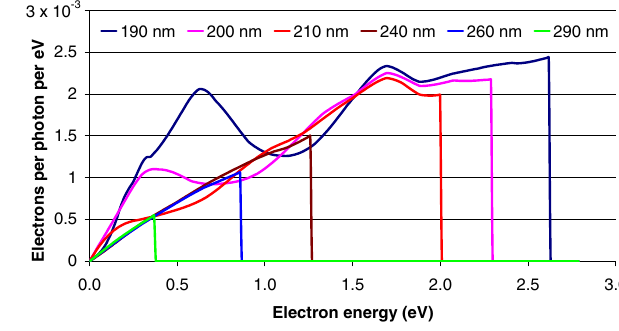
FIG. 2. (Color) Calculated electron mean-free path ( (cid:2) ). lifetime ( (cid:4) e - e